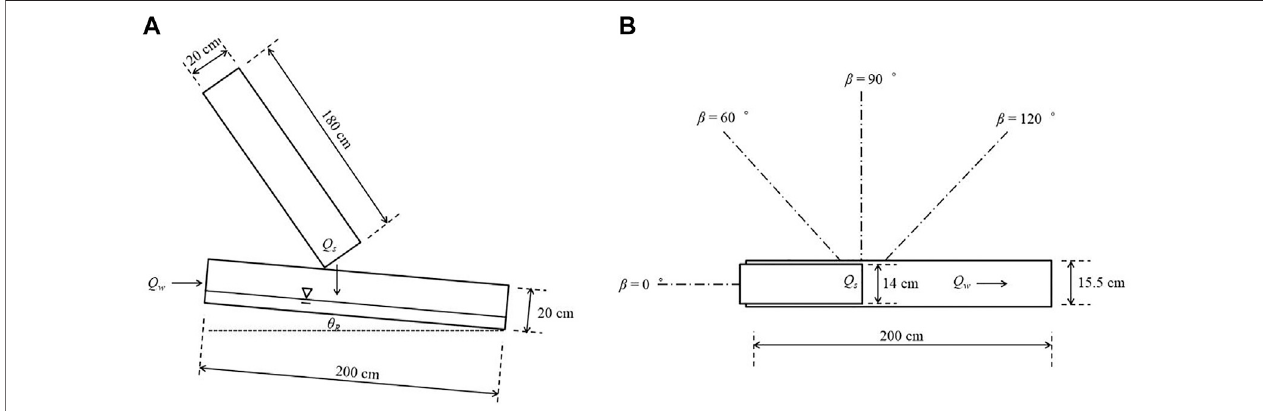
FIGURE 1 | Diagram of the experimental setup on front view (A) and top view (B) , modi fi ed from Chen et al.